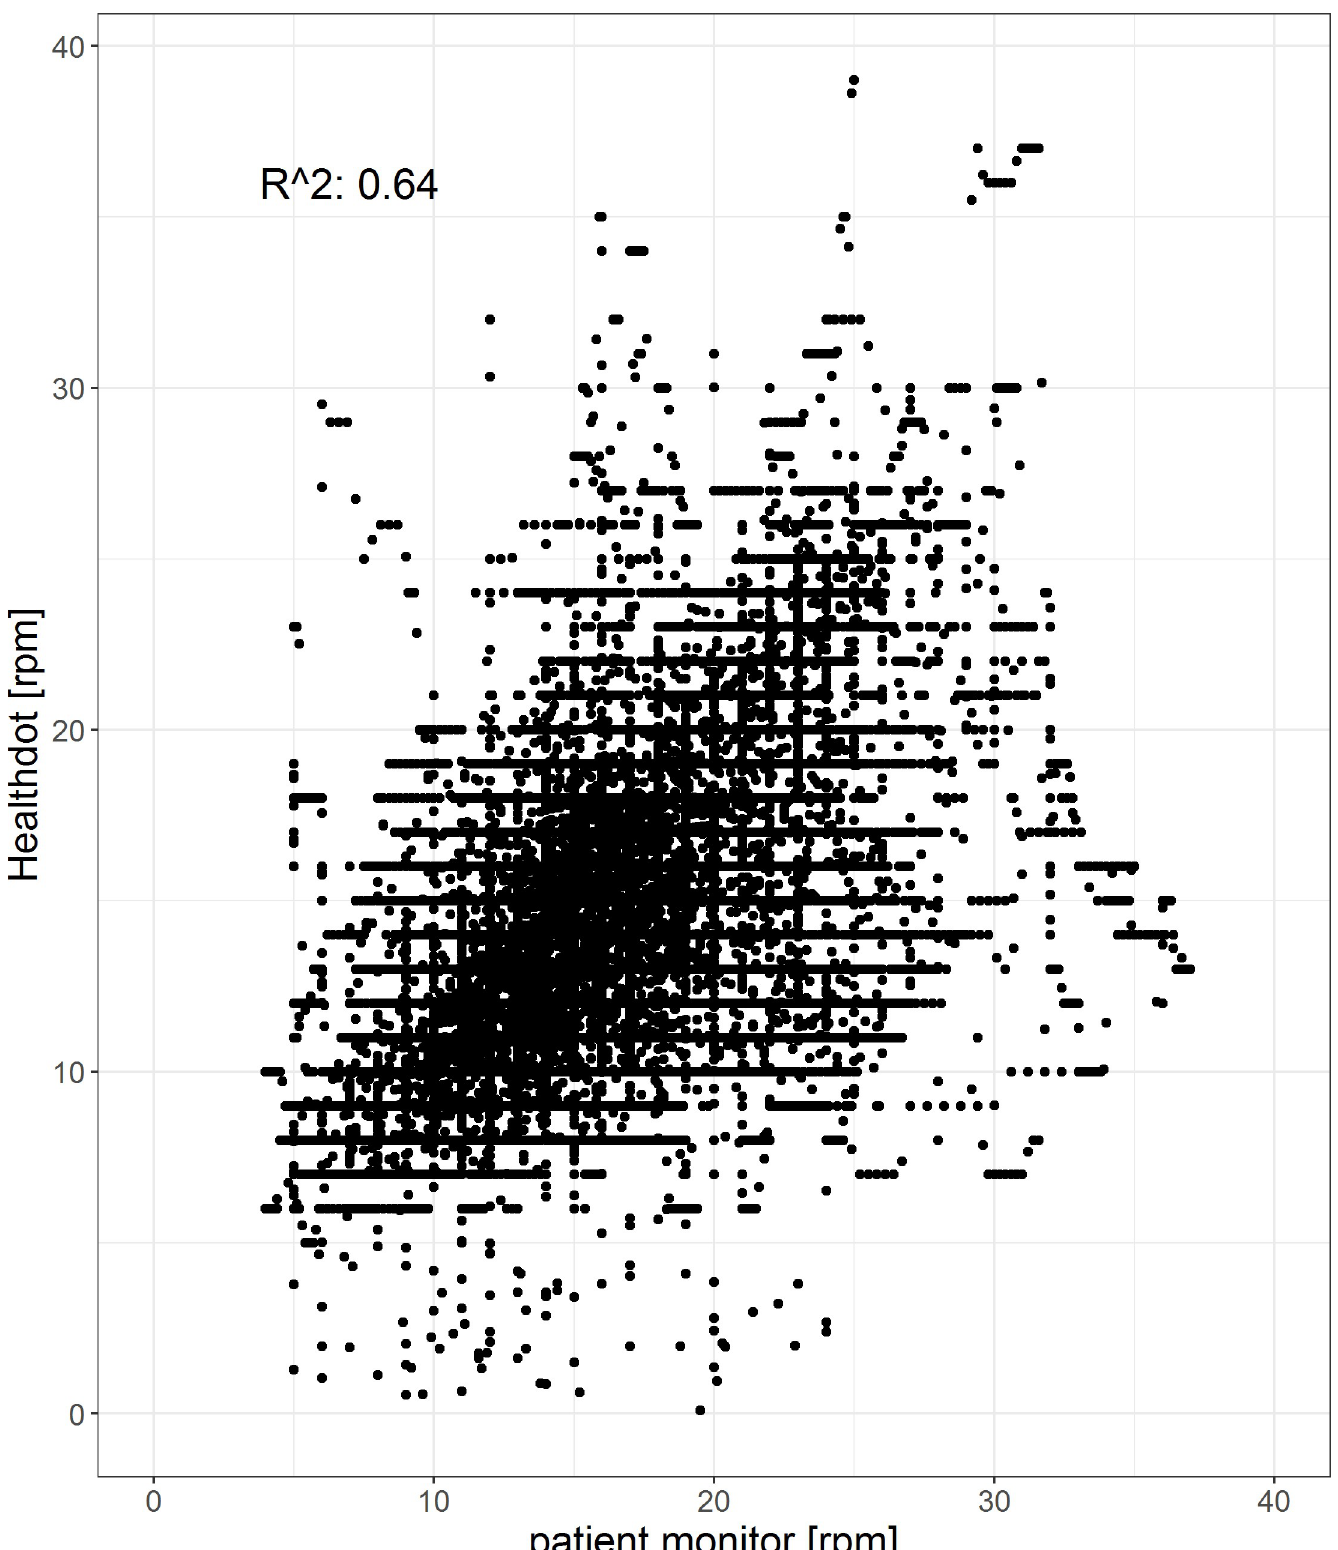
Fig 11. Correlation plot of the RespR. The reference data (x-axis) is plotted against the Healthdot data (y-axis). The corresponding Pearson correlation coefficient is 0.64 (CI: of [0.636: 0.644], p < 0.001). https://doi.org/10.1371/journal.pone.0247903.g011 PLOS ONE | https://doi.org/10.1371/journal.pone.0247903 April 28,